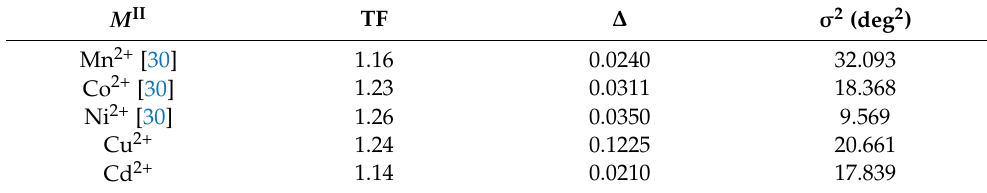
Table 1. Comparison of tolerance factors (TFs), octahedral angle variance σ 2 , and bond length distortion ∆ for MHy M II Cl 3